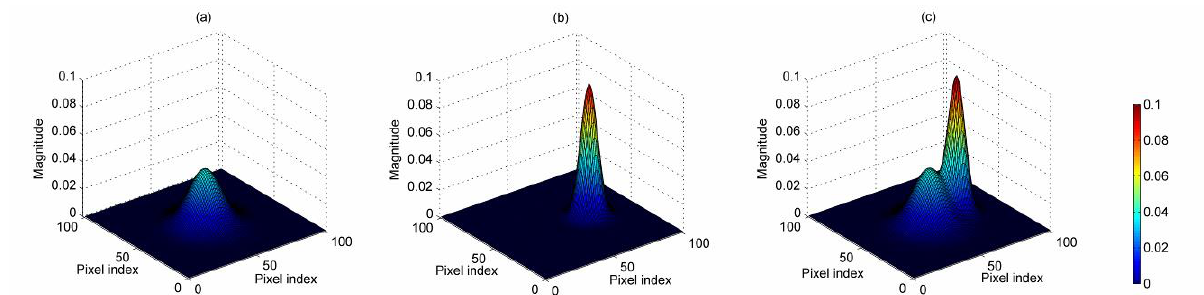
Figure 3: Simple surface containing 2 unit Gaussians. The 2 Gaussians are shown in (a) and (b), respectively. The simple surface as the combination is in